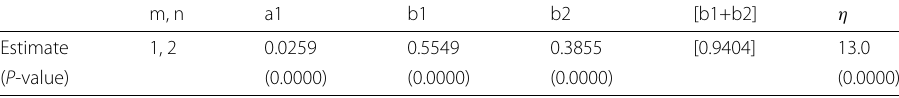
Table 3 DCC parameter estimation